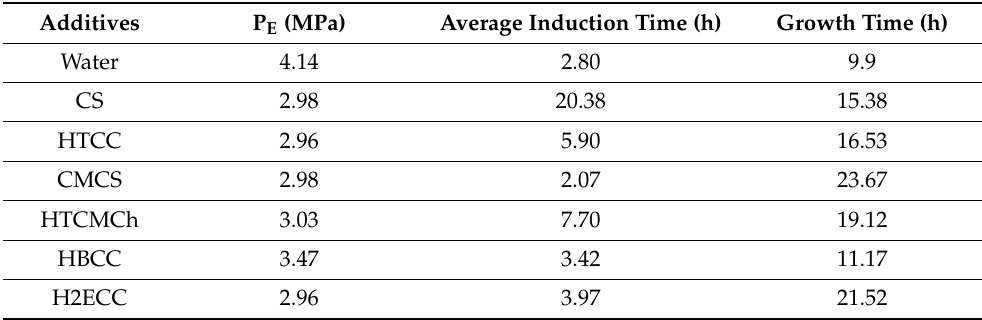
Table 4. The average induction time of hydrate formation in a methane–water system with 0.1 wt% chitosan at 1 ◦ C, 6 MPa, and 400